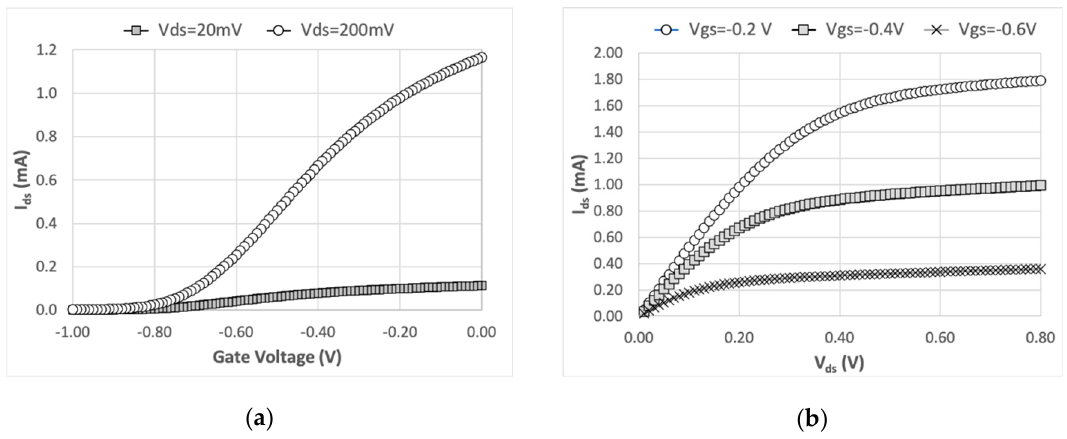
Figure 4. ( a ) Transfer characteristics of the transistors under study for two values of V ds (the drain-to-source voltage). ( b ) Measured output characteristics for three values of V gs (the gate-to-source voltage).